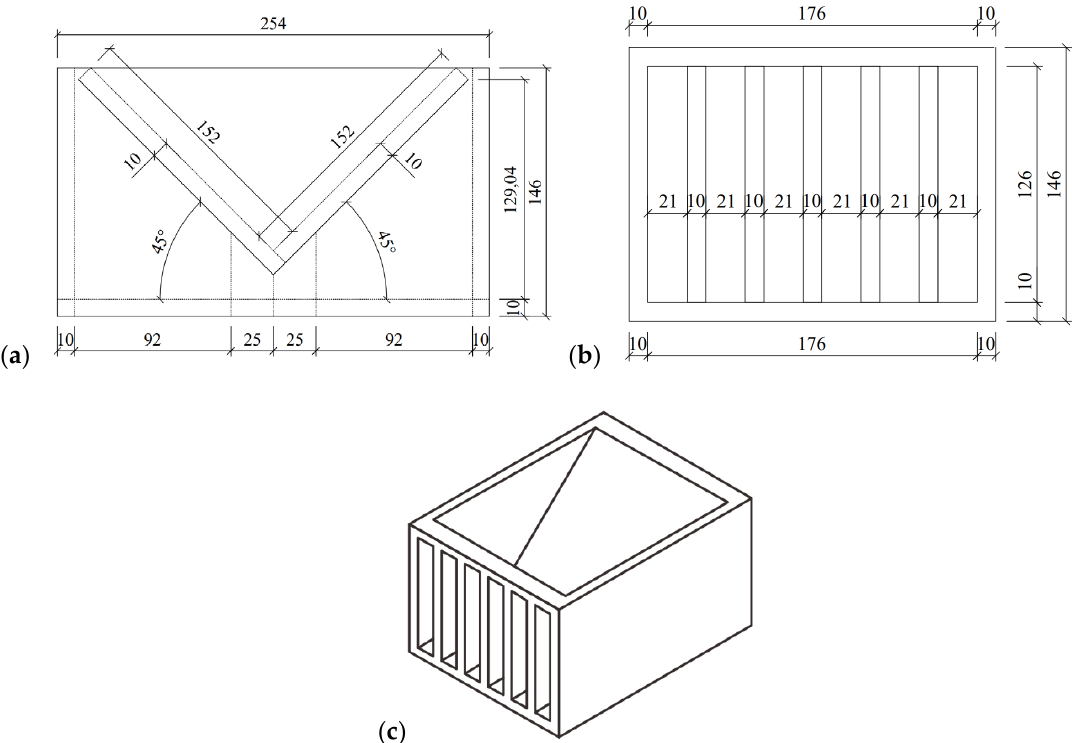
Figure 9. Loading support for the diagonal compressive test: ( a ) Cross Section view; ( b ) Bottom view; ( c ) Isometric view. Units are in mm.